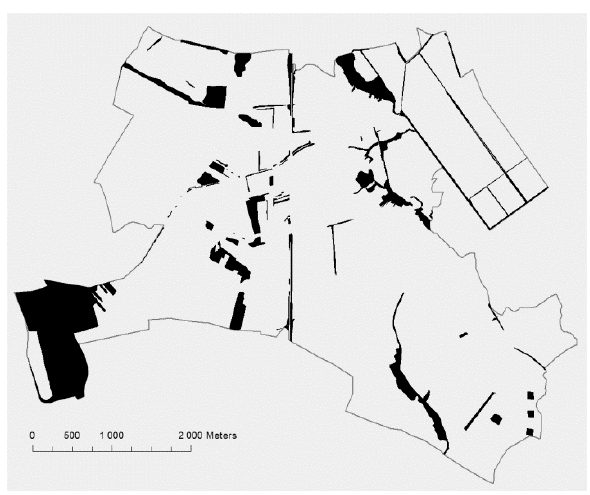
Figure 5. The distribution of green areas in 2014 From the point of view of the landscape, the ecotone parameter is important, i.e. the perimeter of the individual green areas. An ecotone is a transition area between two biomes. An ecotone may appear on the ground as a gradual blending of two boundary line. In 1953 the perimeter of all green areas was 89,974 meters. (Table 1) The perimeter of green areas has